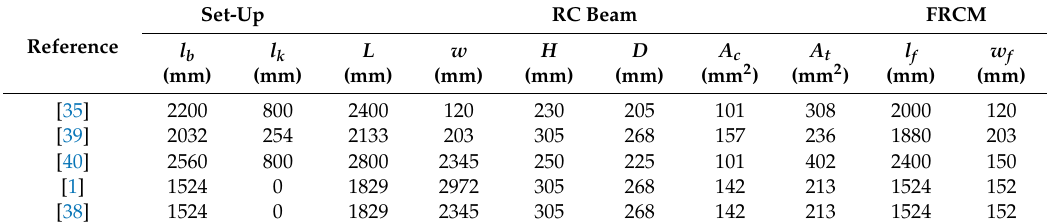
Figure 1. Bending test set-up of the experimental tests collected. Table 1. Geometrical parameters depicted in Figure 1.